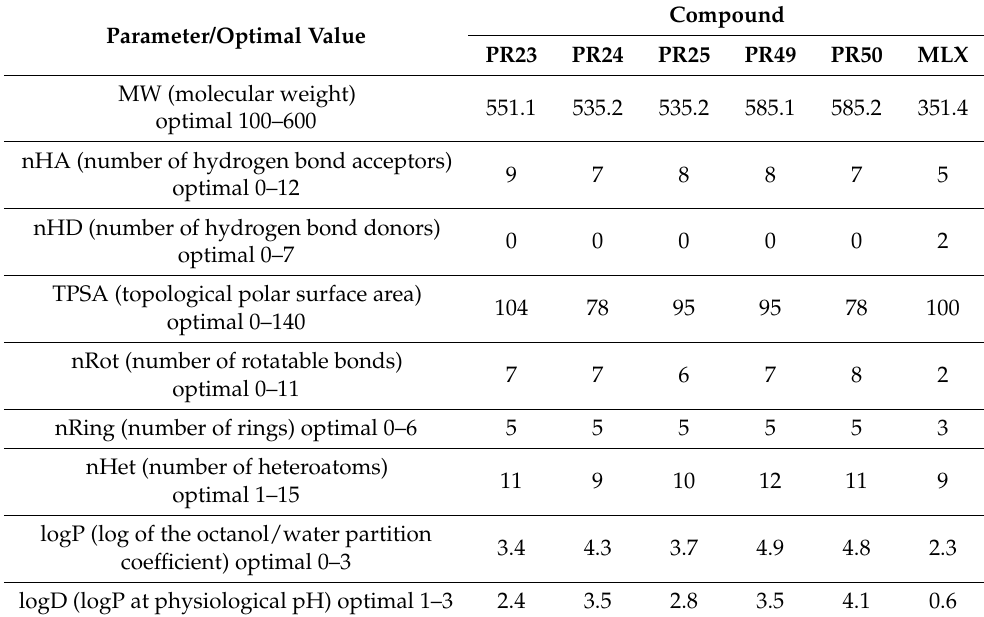
Table 1. Physicochemical properties of studied compounds and meloxicam (MLX). Parameter/Optimal Value